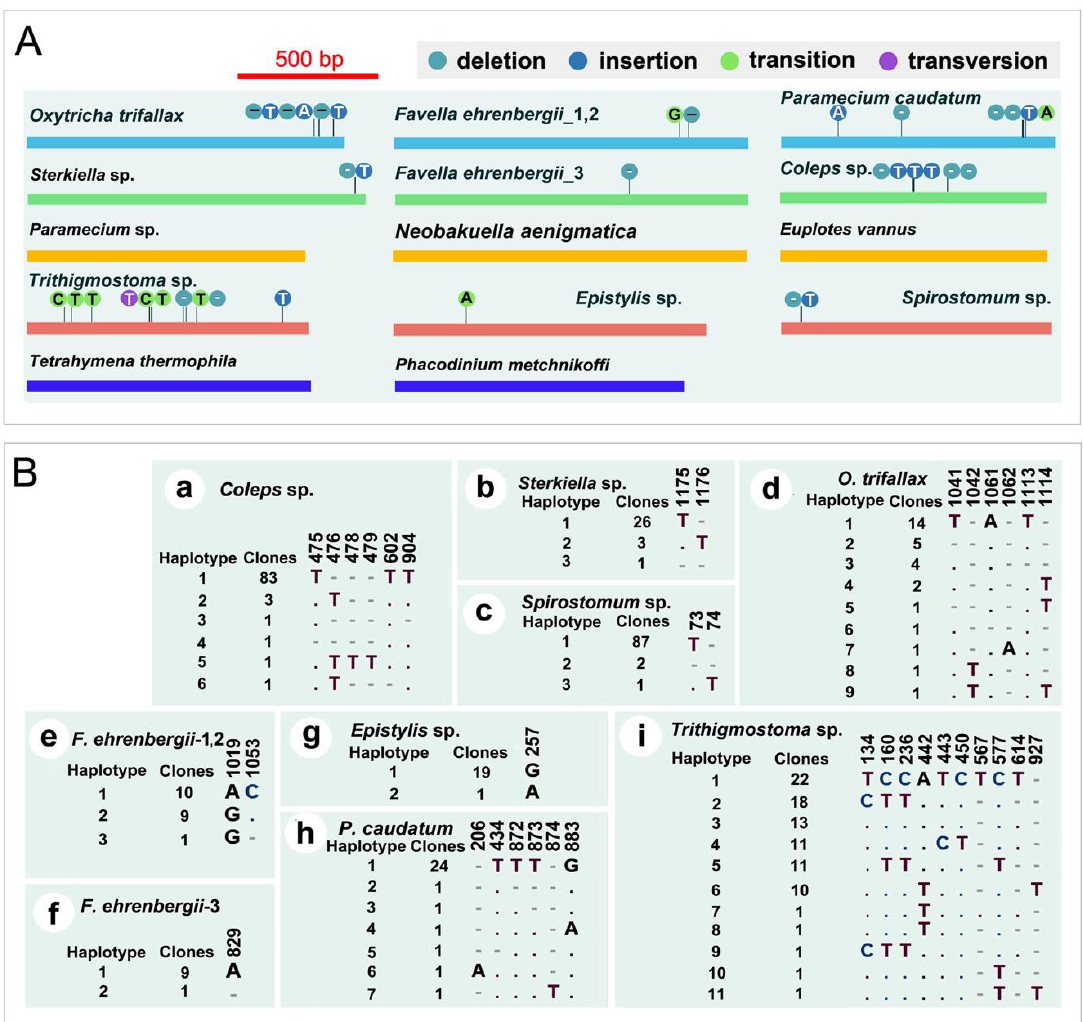
Figure 2. The mtSSU rDNA polymorphisms among 13 focal species. ( A ) Bars indicate the most common sequences of each species, bright blue, dark blue, green, and purple dots represent deletion, insertion, transition, and transversion, respectively, while the nucleotides shown in dots represent the polymorphism compared with the common sequence; lengths of sequences are drawn to scale. ( B ) Polymorphic sites between di ff erent haplotypes. Clones mean the number of clones for the corresponding haplotype found in total clones (20, 30, or 90); For F. ehrenbergii , the first two individuals and the third one might be cryptic species (i.e., they were indeed di ff erent species), so we represented them respectively; matching sites are represented by dots (.) and missing sites are marked with dashes (-); a: Coleps sp.; b: Sterkiella sp.; c: Spirostomum sp.; d: Oxytricha trifallax ; e, f: Favella ehrenbergii ; g: Epistylis sp.; h: Paramecium caudatum ; and i: Trithigmostoma